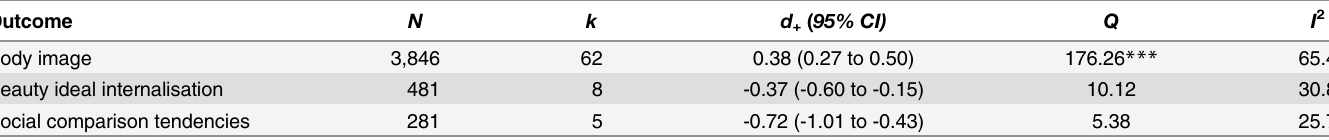
Table 3. Overall Effect of Interventions on